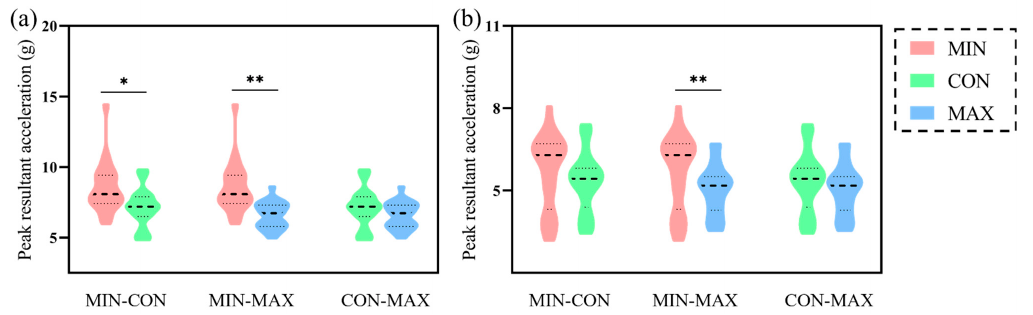
Figure 3. Violin plots of the Bonferroni comparisons for peak resultant acceleration between conditions in the distal ( a ) and proximal ( b ) tibia. Note: MINs: the minimalist shoes; CONs: the conventional shoes; MAXs: the maximalist shoes. * p < 0.05 and ** p < 0.01. The black dashed line represents the median, and the gray dashed lines above and below represent the third and first quartiles.